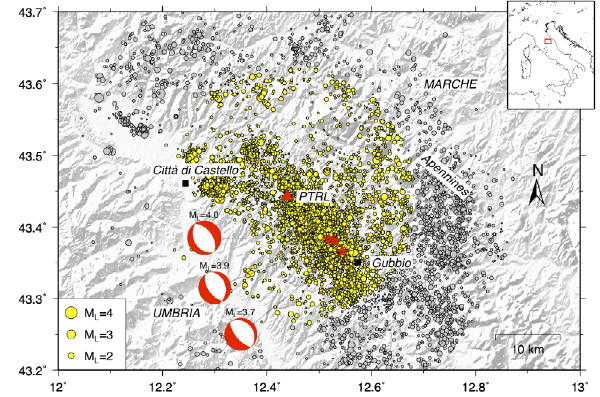
Figure 1. Map of the study area located in the Italian region Umbria (see inset) showing: i) the location of the radon monitoring station Pietralunga (PTRL) (red triangle); ii) the seismicity recorded by ISIDe [ISIDe 2010] between January 1, 2011 and December 31, 2013. Yellow dots represent earthquakes with epicentral distance from the PTRL station of less or equal to 20 km (8,295 events); iii) the focal ≥ 3.7 earthquakes (http://cnt.rm.ingv.it/) mechanisms of the M l occurred during the selected period. See Table 1 for details. The plot was made using the Generic Mapping Tools version 4.2.1 (www.soest.hawaii.edu/gmt; Wessel and Smith